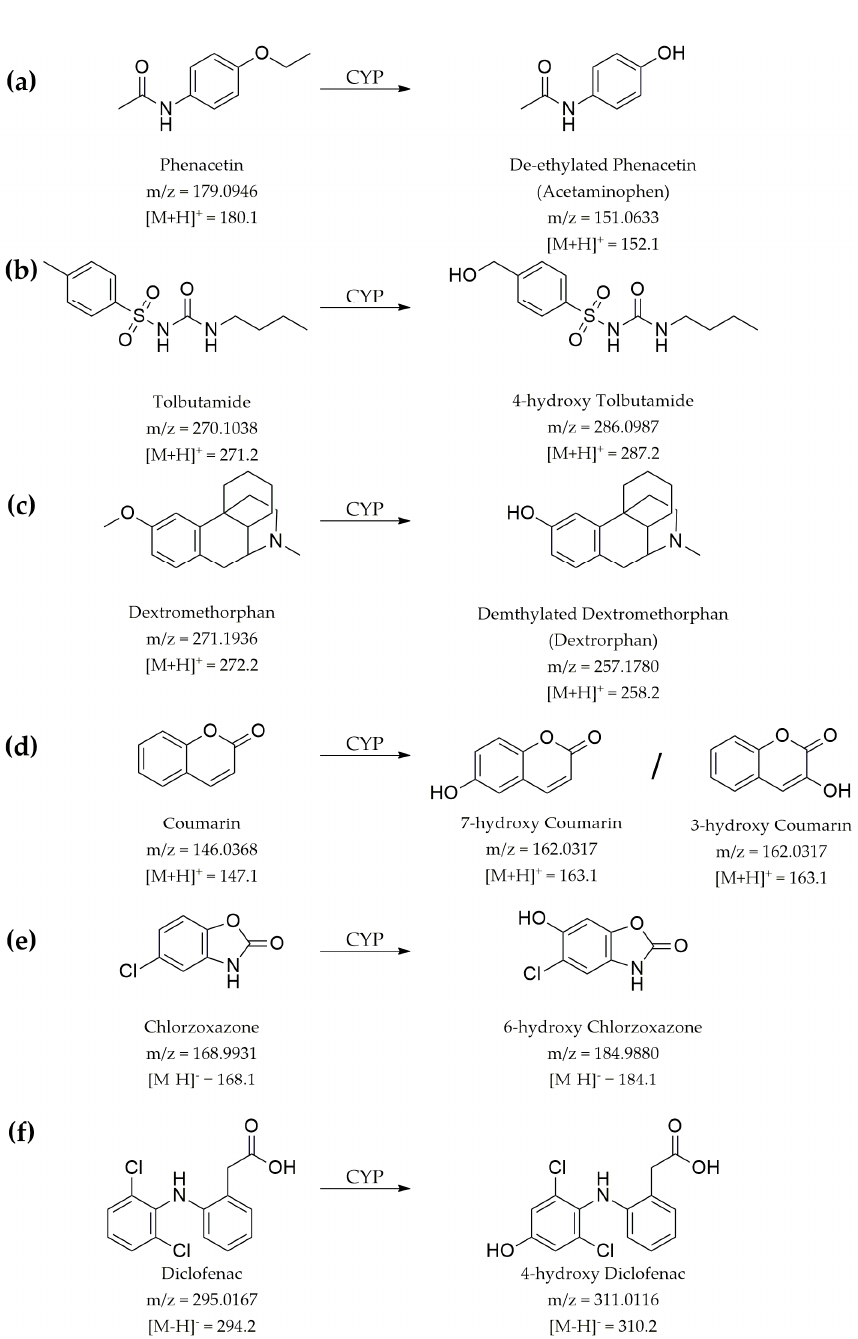
Figure 3. Microsomal (CYP-mediated) biotransformation of the control CYP substrates. Chemical structure, compound name, exact mass (m/z), observed positively ([M+H] + ) or negatively ([M-H] - ) charged species and major metabolites for (a) Phenacetin, (b) Tolbutamide, (c) Dextromethorphan, (d) Coumarin, (e) Chlorzoxazone and (f) Diclofenac.